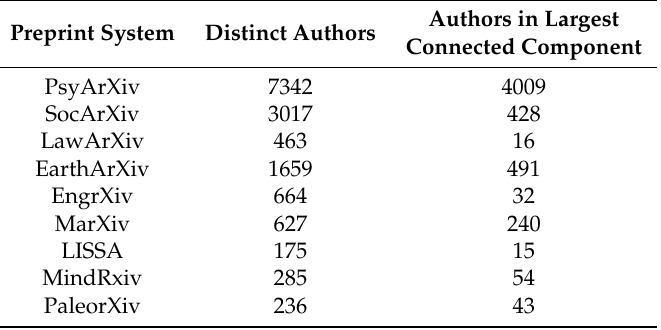
Table 5. Coauthorship network statistics for 9 COS services.